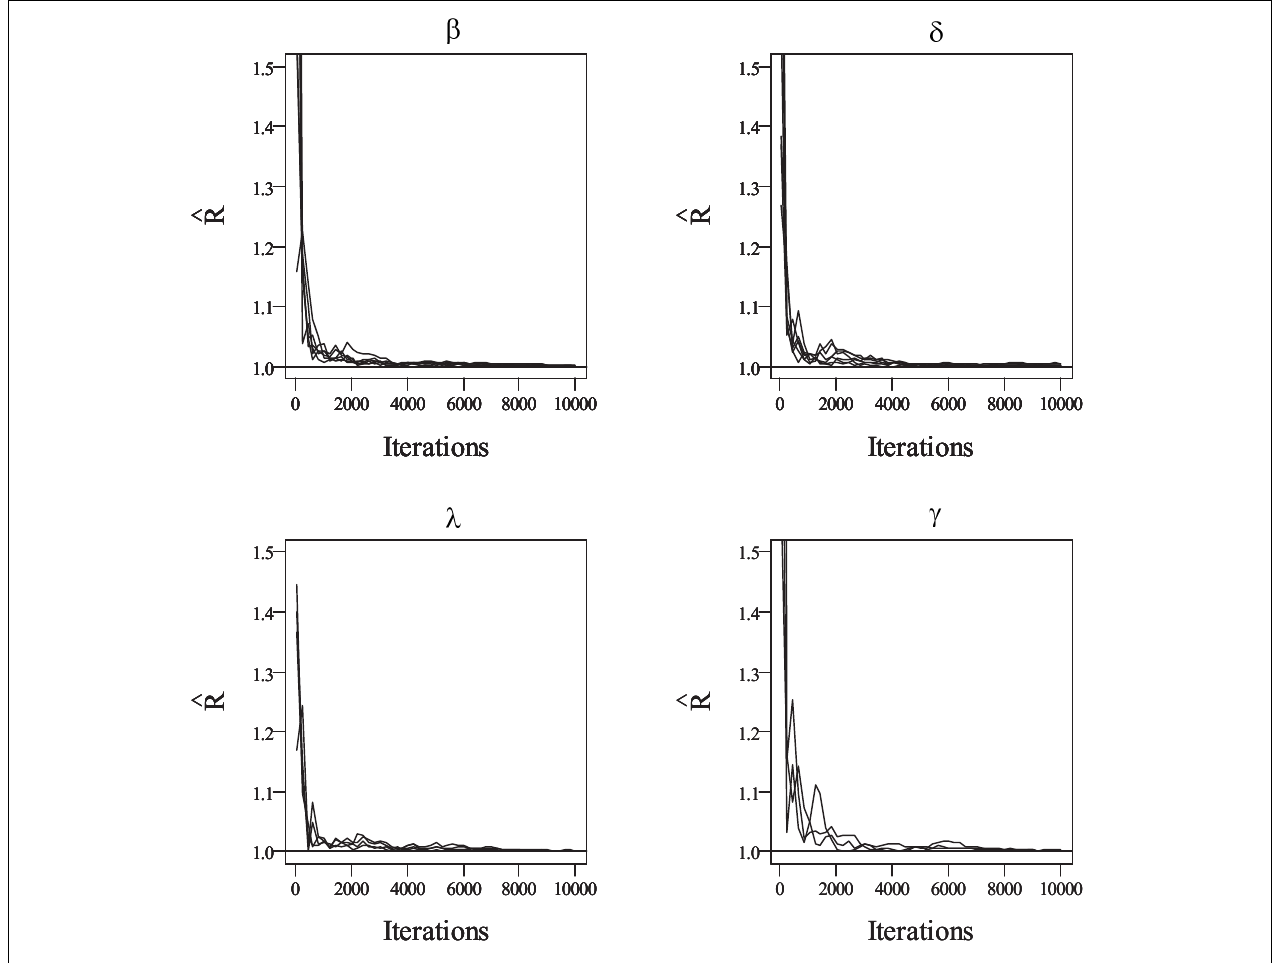
FIGURE 2 | The trace plots of PSRF values for simulation study